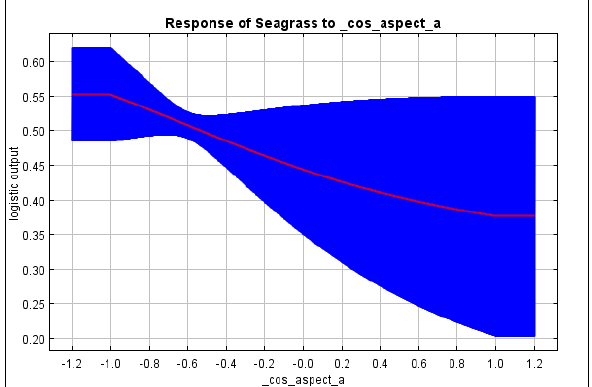
Figure 9. Response curves of cosine of aspect for the seagrass habitat suitability model.